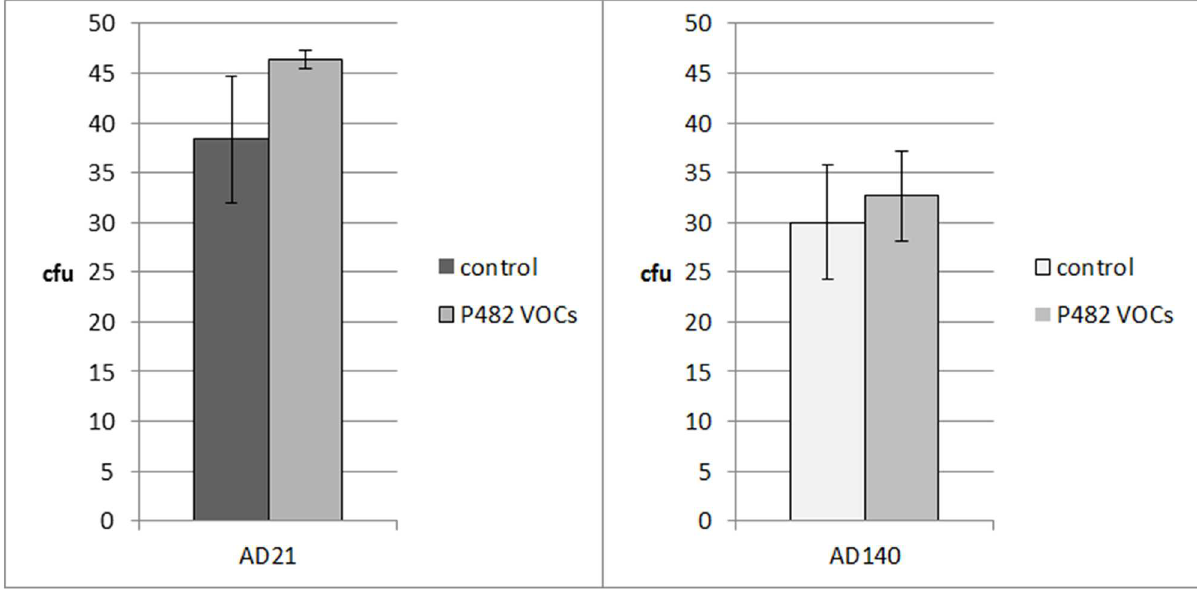
Fig 2. Number of colony forming units (cfu) of Pseudomonas fluorescens AD21 and Agrobacterium sp. AD140 after overnight exposure to volatiles emitted by P . donghuensis P482 and control without bacterial volatiles. Error bars represents standard deviationof the